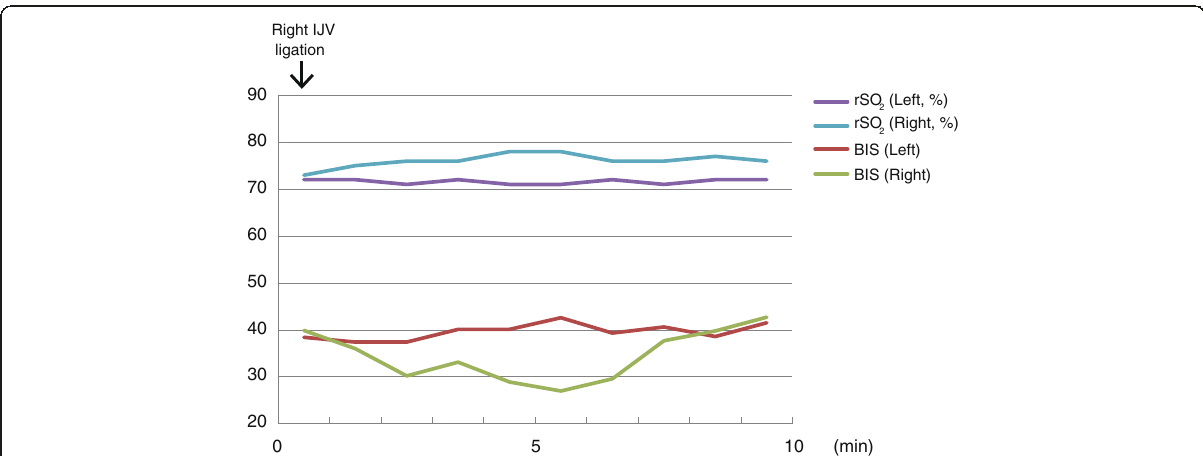
Fig. 2 rSO 2 and BIS values after ligation of the IJV. Changes in regional cerebral oxygen saturation (rSO 2 ) and bispectral index (BIS) 10 min after the internal jugular vein (IJV) ligation are